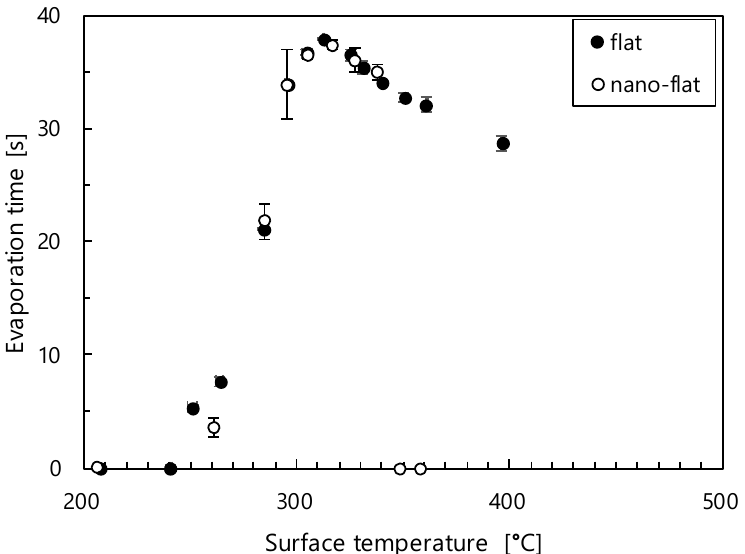
Figure 5. Evaporation time as a function of surface temperature on flat and nanoflat surfaces.